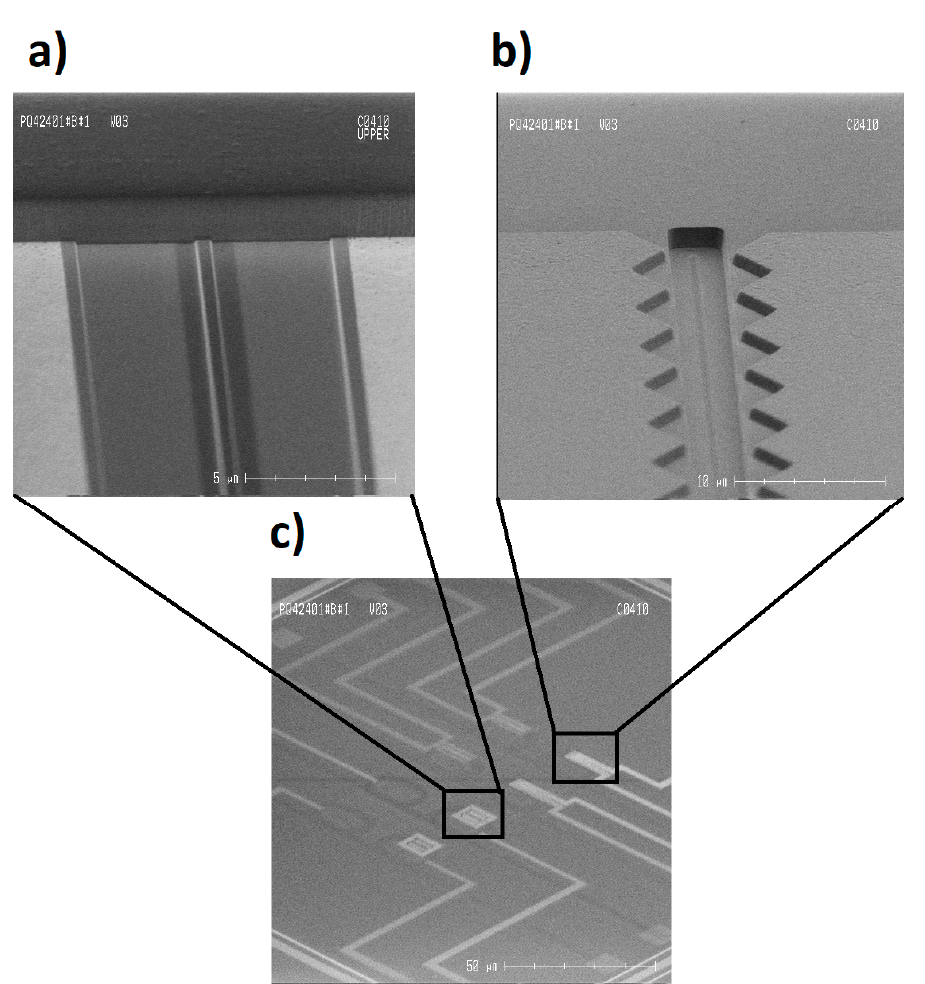
Figure 8. SEM image of the fabricated sensors. ( a ) The sensor region in the doped waveguide, corresponding to Figure 3c. The core waveguide can be observed at the center as a bright line next to a thin dark gray area representing the undoped rib. The brighter gray area is attributed to the doped rib, while the whiter region is attributed to the salcide segment. ( b ) The coplanar electrodes: A 4 × 90 µ m large window that is etched with reactive ion etching (RIE) that exposes the core waveguide can be observed at the center of the opening. ( c ) An overview of the chip layout, showing the ring resonators, sensing areas, and electrode